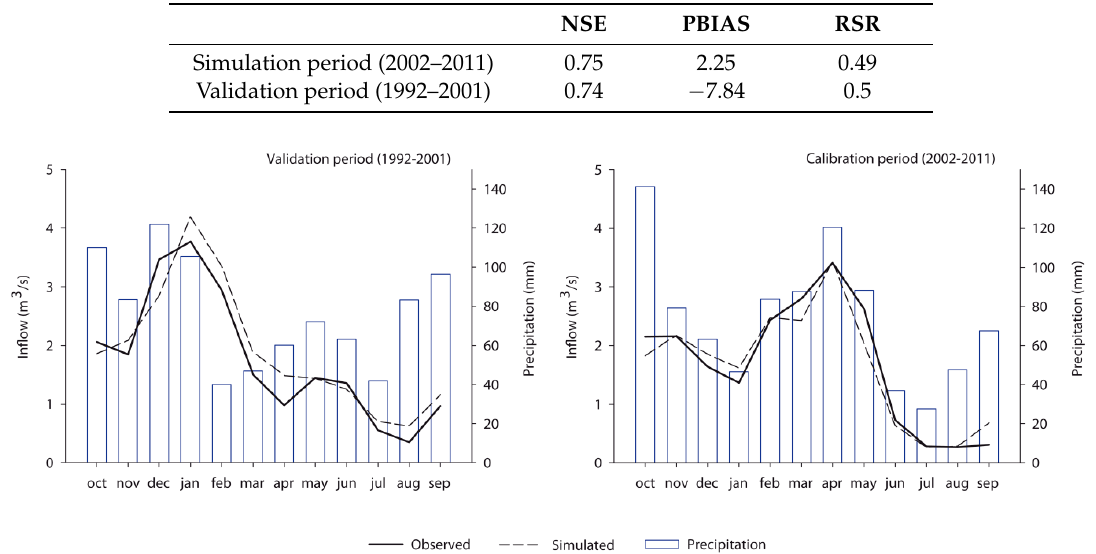
Figure 6. Mean monthly streamflow and precipitation for calibration/validation periods.